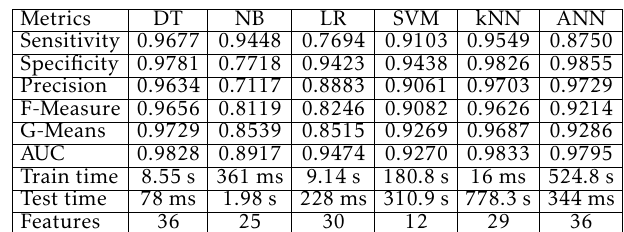
Table 31. Results of using IG-BFE algorithm on EXPLOITS.